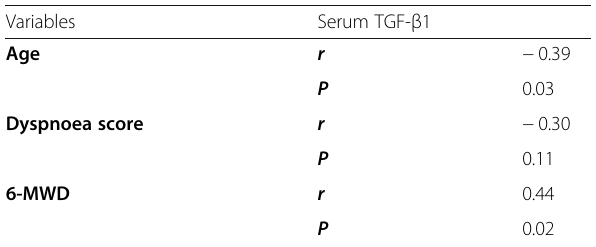
Table 4 Correlation between serum levels of TGF- β 1 with the clinical data